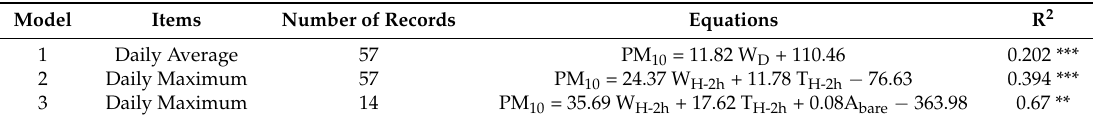
Table 1. Estimations model of PM 10 concentration on different temporal scales (W D : daily